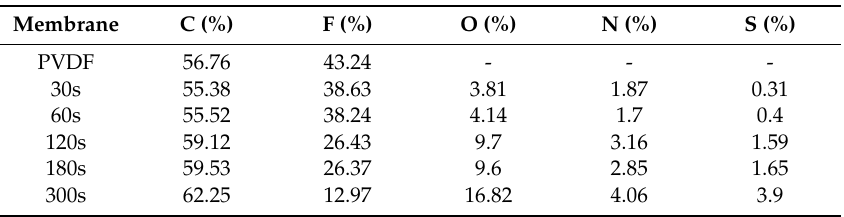
Table 1. The XPS spectrum was evaluated using the elemental ratio of the unmodified PVDF and PSBMA-modified